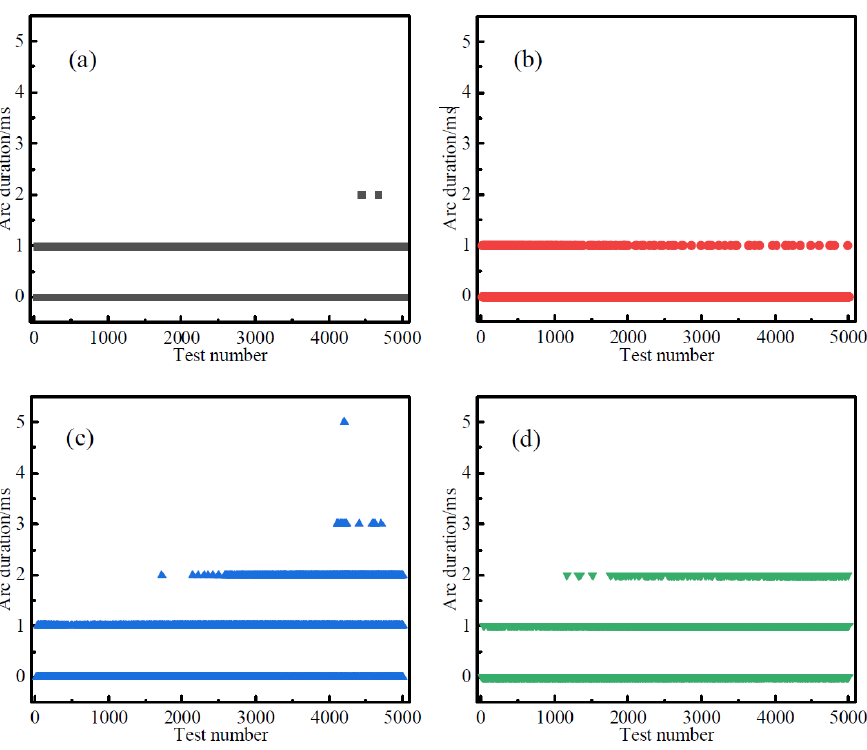
Figure 8. Change in arc time of Cu-W composite contacts: ( a ) Cu; ( b ) Cu-10 wt% W; ( c ) Cu-20 wt% W; ( d ) Cu-30 wt% W.